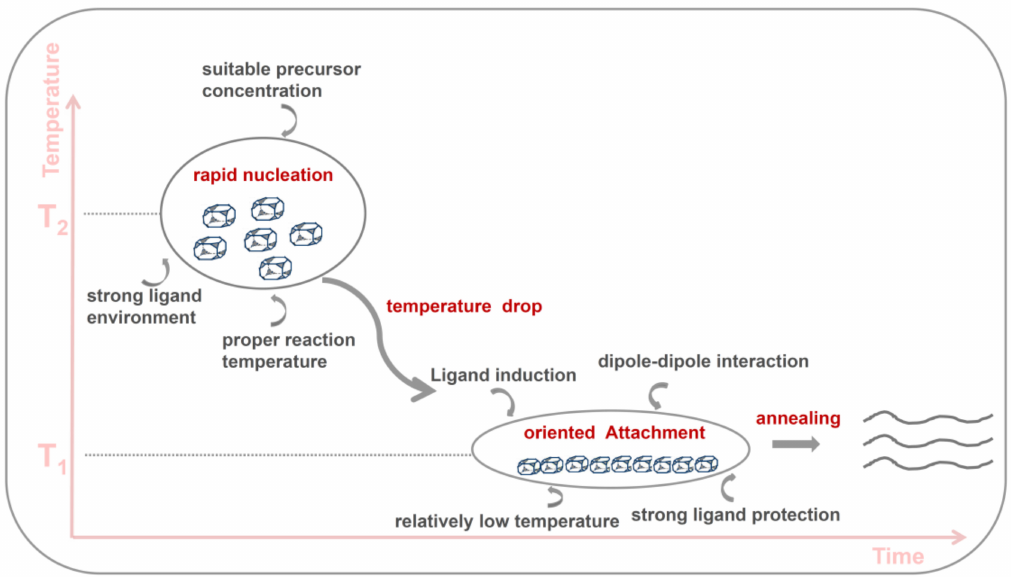
Scheme 1. Sketch highlighting the special reaction conditions under which the formation of